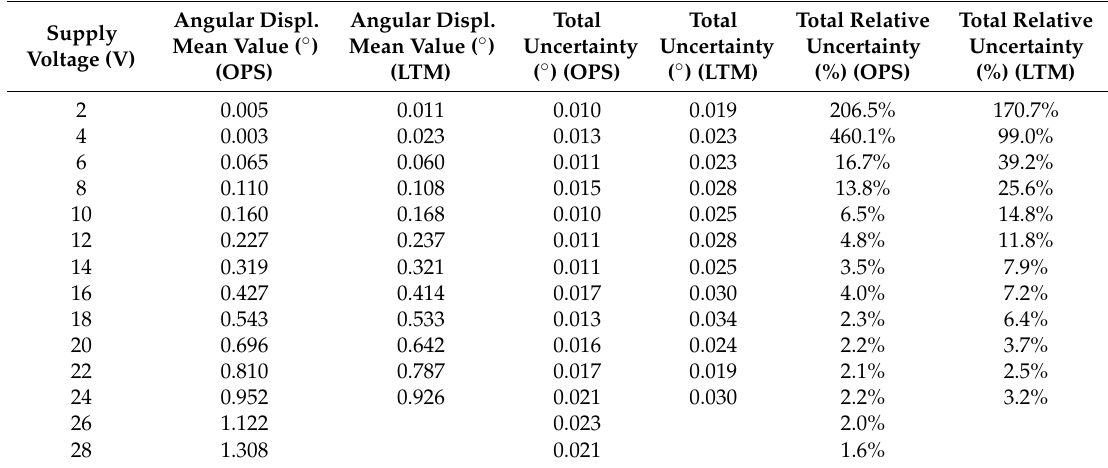
Table 4. Angular rotation, Total Uncertainty, expressed as standard deviation, and Total Relative Uncertainty of comb-drive depending on the applied